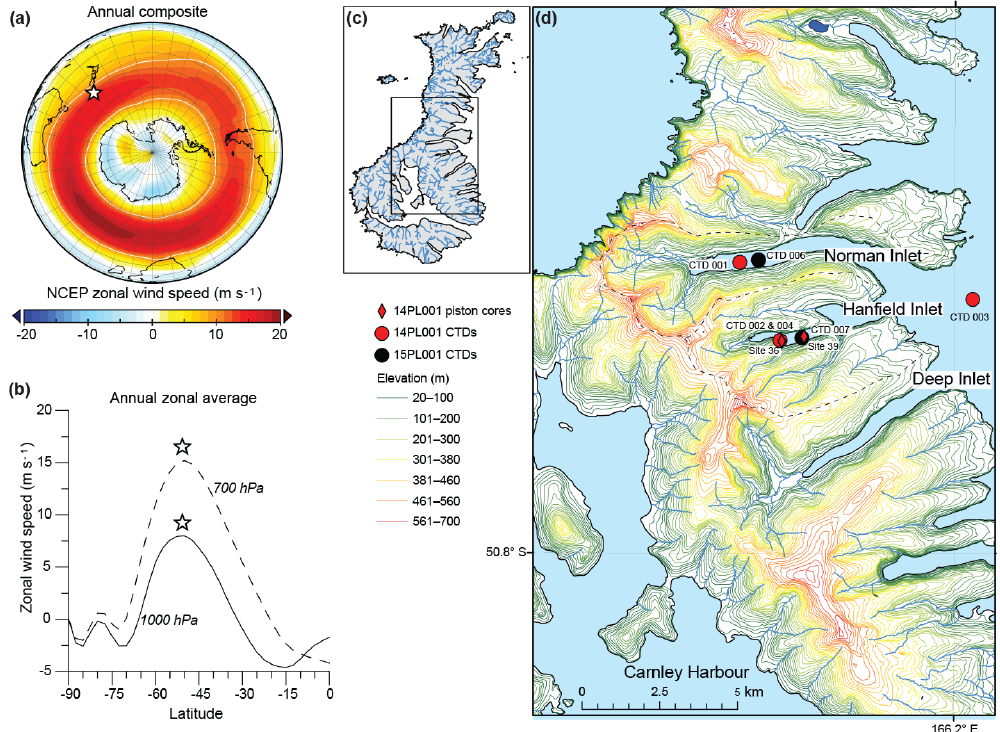
Figure 1. (a, b) Annual average of 700hPa zonal wind speed. Data sourced from the NCEP/NCAR reanalysis (Kalnay et al., 1996). The star denotes the position of New Zealand’s subantarctic Auckland Islands (51 ◦ S, 166 ◦ E). (c) Map of Auckland Islands with study area highlighted. (d) Piston coring (diamonds) and CTD (circles) sites. Core 36P4 was collected at Site 36 and Core 39P4 was collected at Site 39. Data were collected in February of 2014 (cruise 14PL001, red symbols) and 2015 (cruise 15PL001, black symbols). Dashed black lines outline the catchment areas for Norman and Hanfield